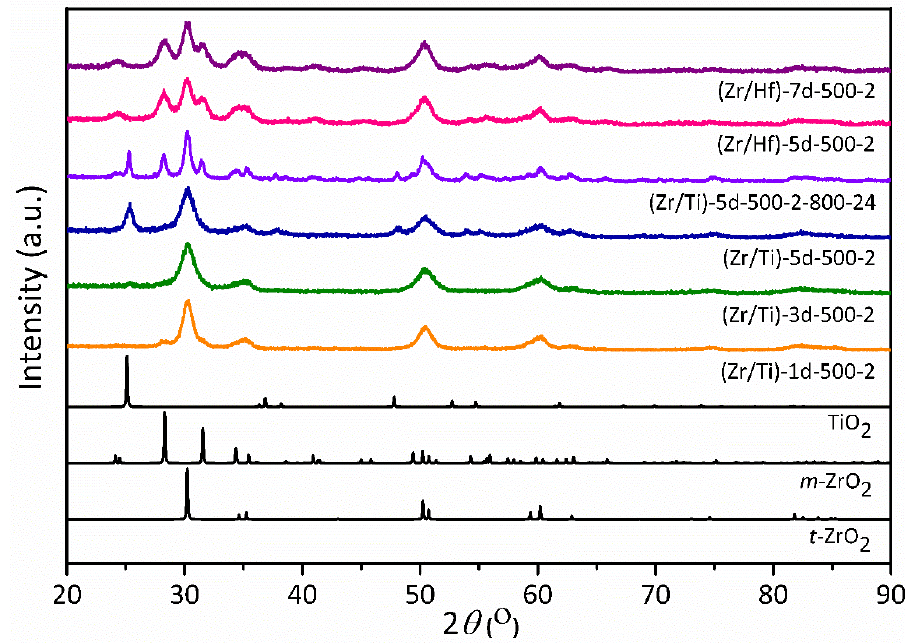
Figure 3. PXRD patterns of ZrO 2 -TiO 2 and ZrO 2 -HfO 2 composites. Table 2. The volume ratio of binary oxide catalysts.